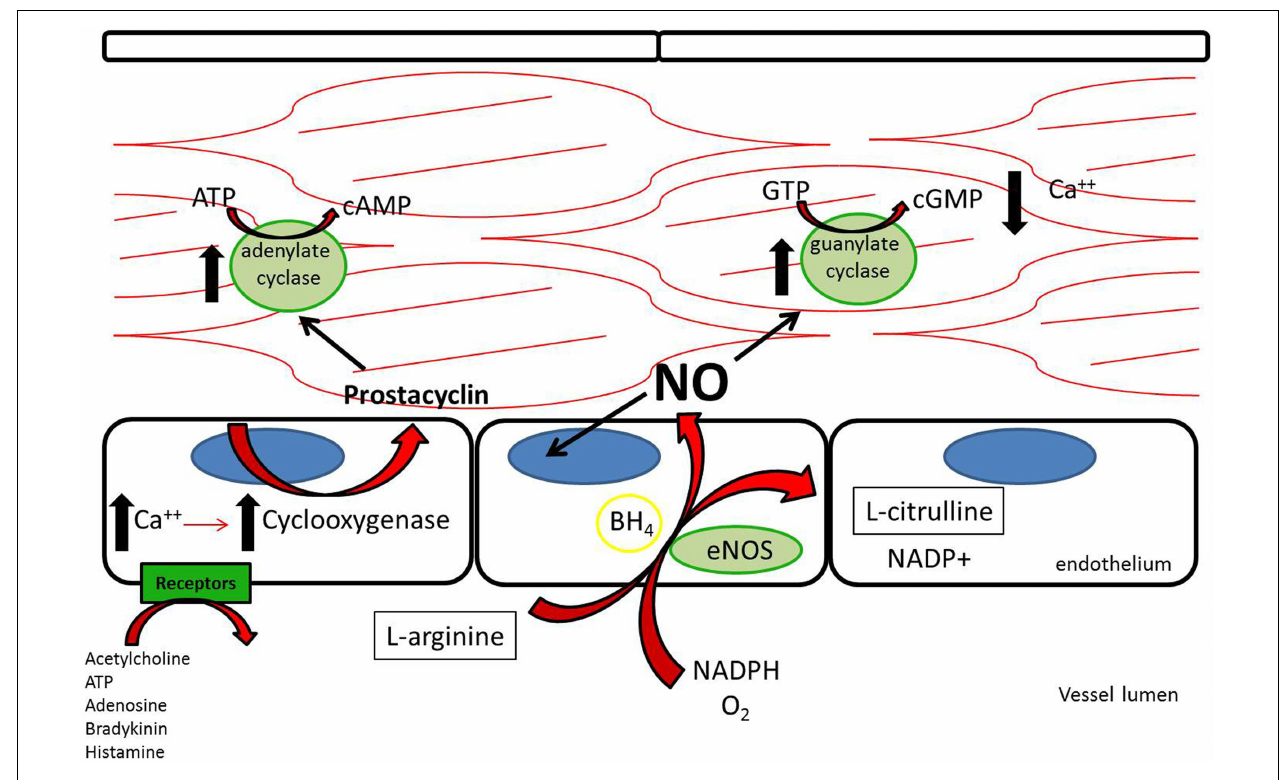
induce vasodilation . Acetylcholine, adenosine triphosphate, adenosine, bradykinin, and histamine all act on different receptors to generate downstream prostacyclin, which acts as a redundant system to induce vasodilation and platelet inhibition